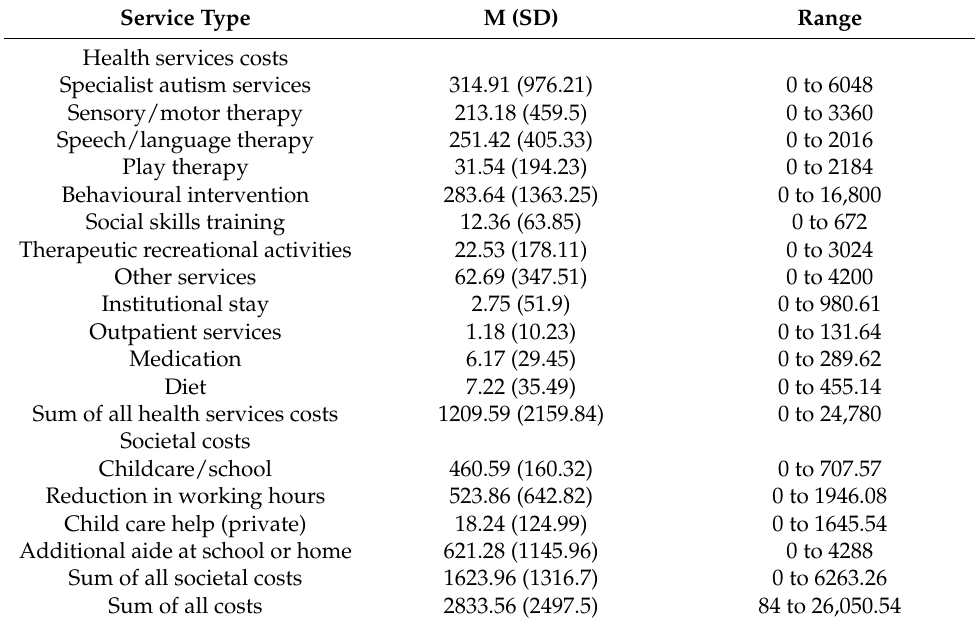
Table 3. Health services and societal costs received 357 children with ASD.